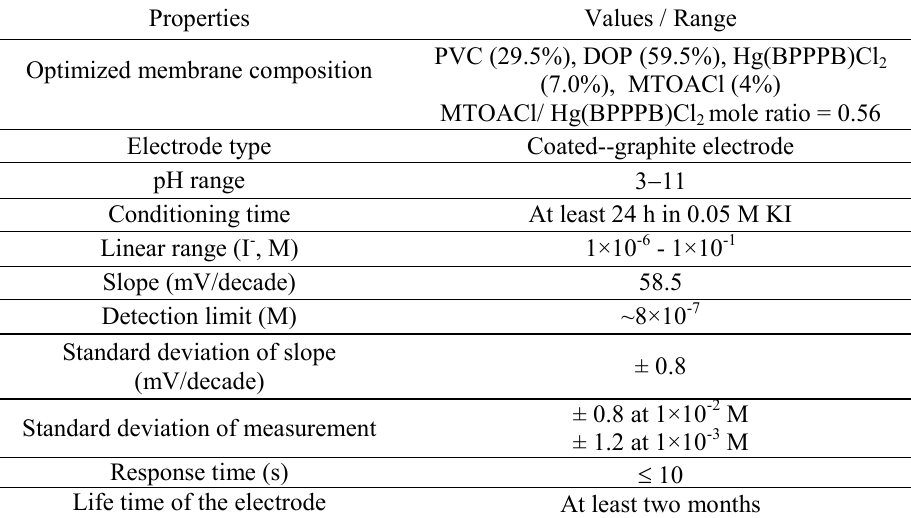
Table 2. Specifications of the iodide ion-selective